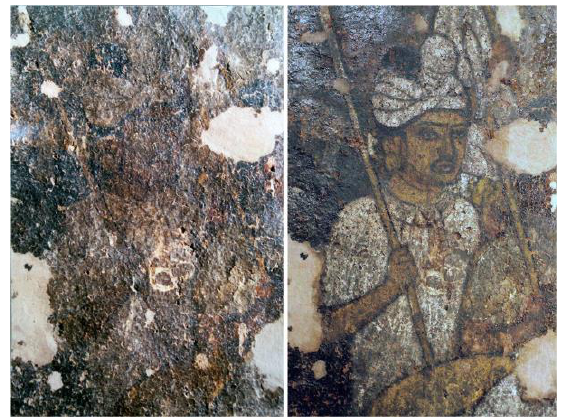
Figure 16. Scientific conservation of murals of cave 10,